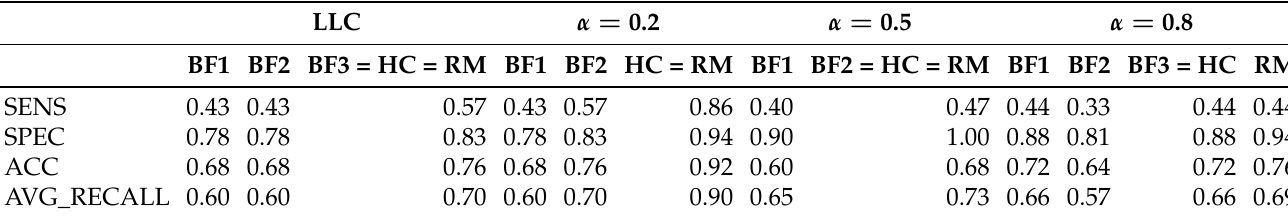
Table 10. Bayes network (brute force networks (BFi) and hill climbing (HC)) performances with respect to Granger graph ground truth computed rfor each synthetic data set: LLC and GCD_LLC_ α for α = ( 0.2,0.5,0.8 )